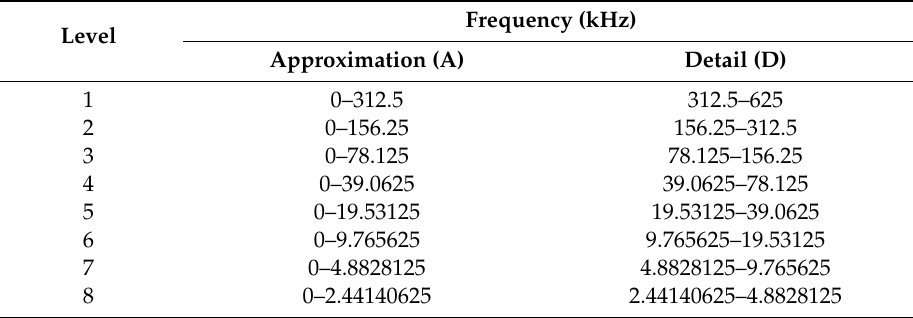
Table 2. Frequency bands of components at each level.